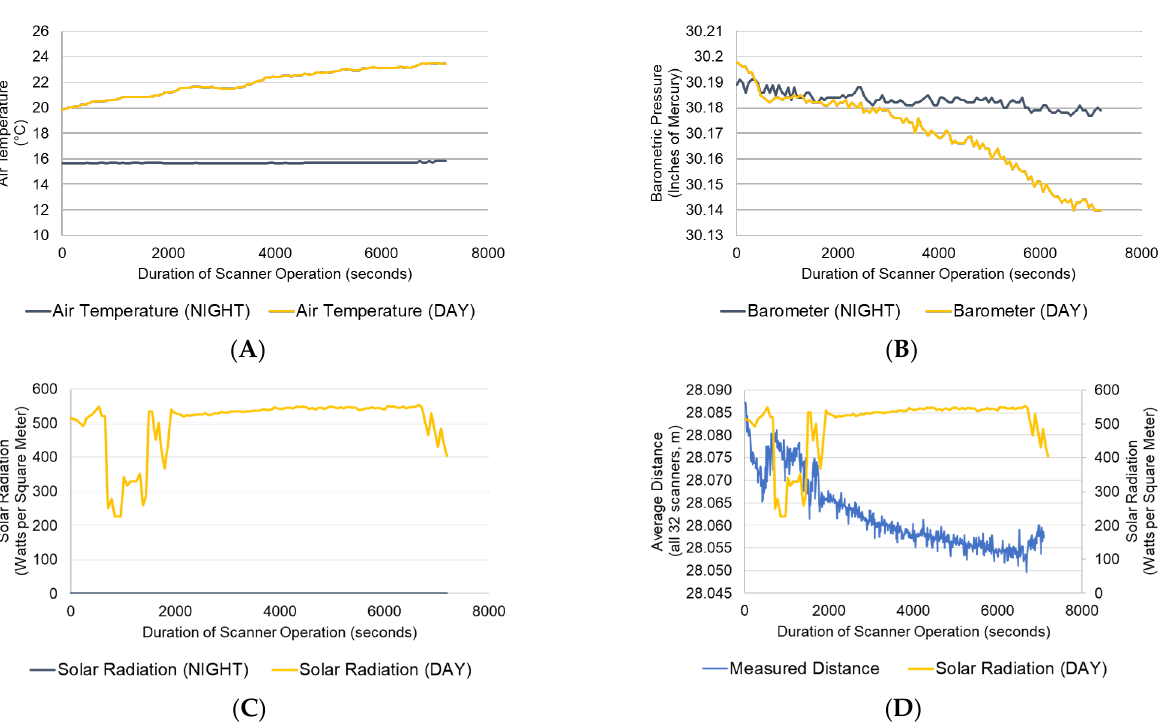
Figure 23. Weather conditions during Velodyne ® HDL–32E night and day absolute accuracy experiments: ( A ) air temperature (°C), ( B ) barometric pressure (inches of mercury), and ( C ) solar radiation (watts per square meter) at study site. ( D ) Comparison between solar radiation and measured distance.